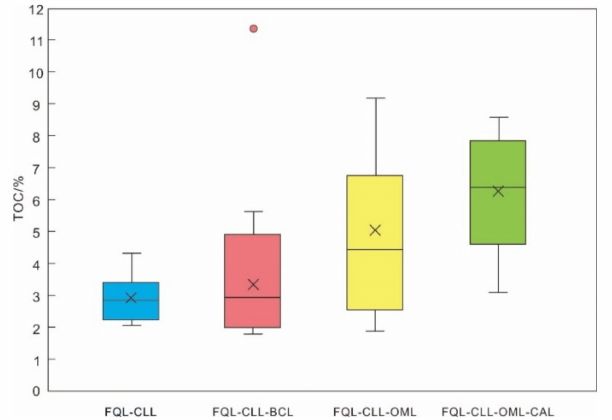
Figure 5. Box plots of TOC in different laminae combinations, occurrence of an outlier in the FQL- CLL-BCL combination. FQL: feldspar-quartz laminae; CLL: clay laminae; CAL: carbonate laminae; OML: organic matter laminae; BCL: bioclastic